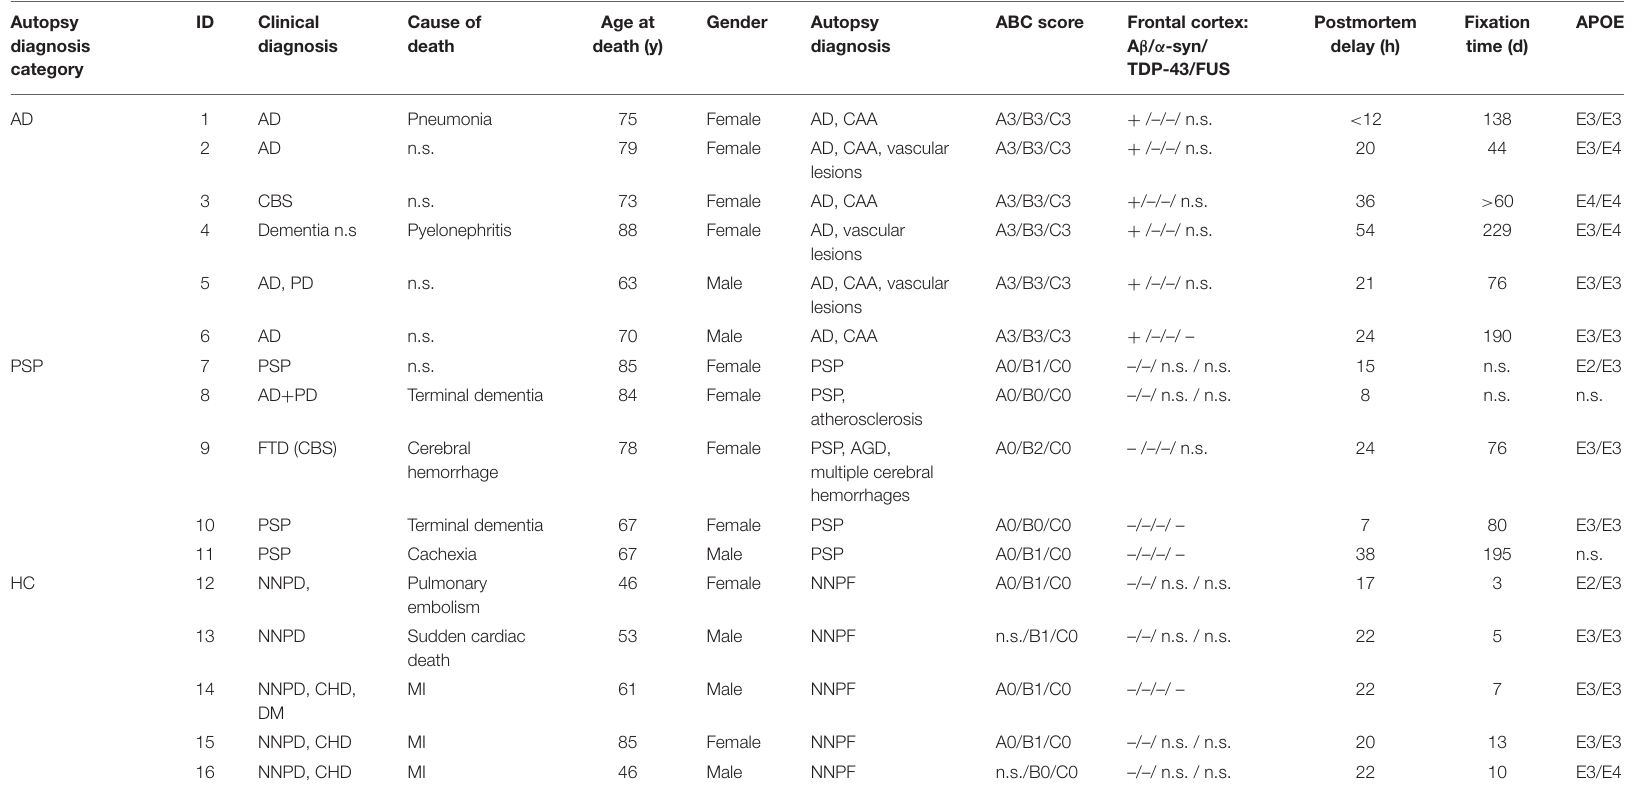
TABLE 1 | Patient